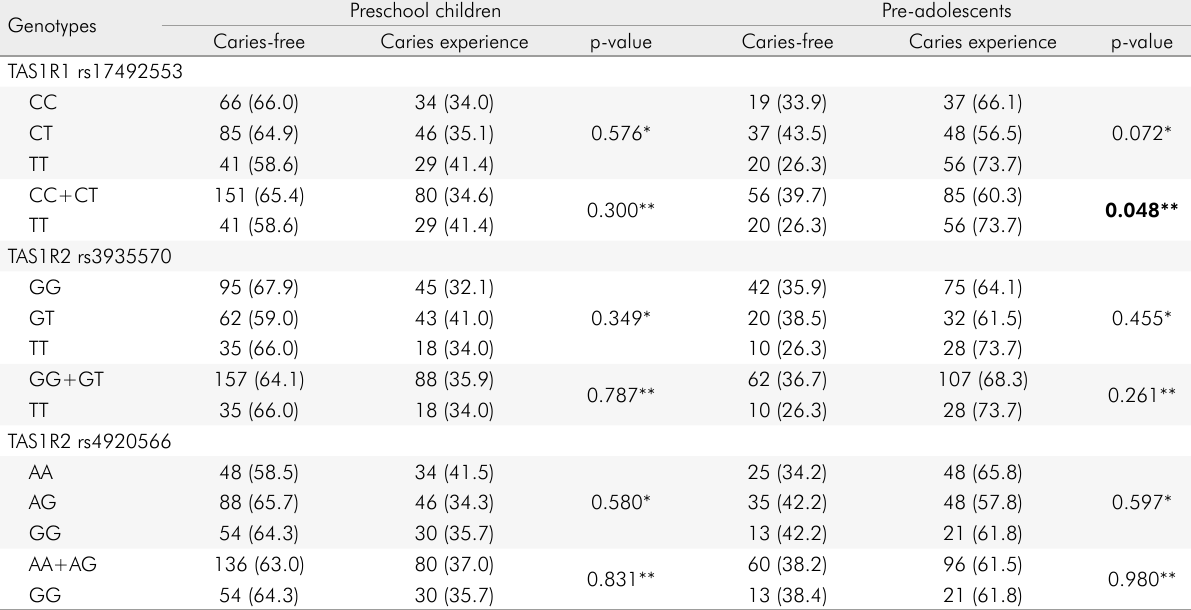
Table 2. Genotype distributions in children and pre-adolescents according to caries experience.